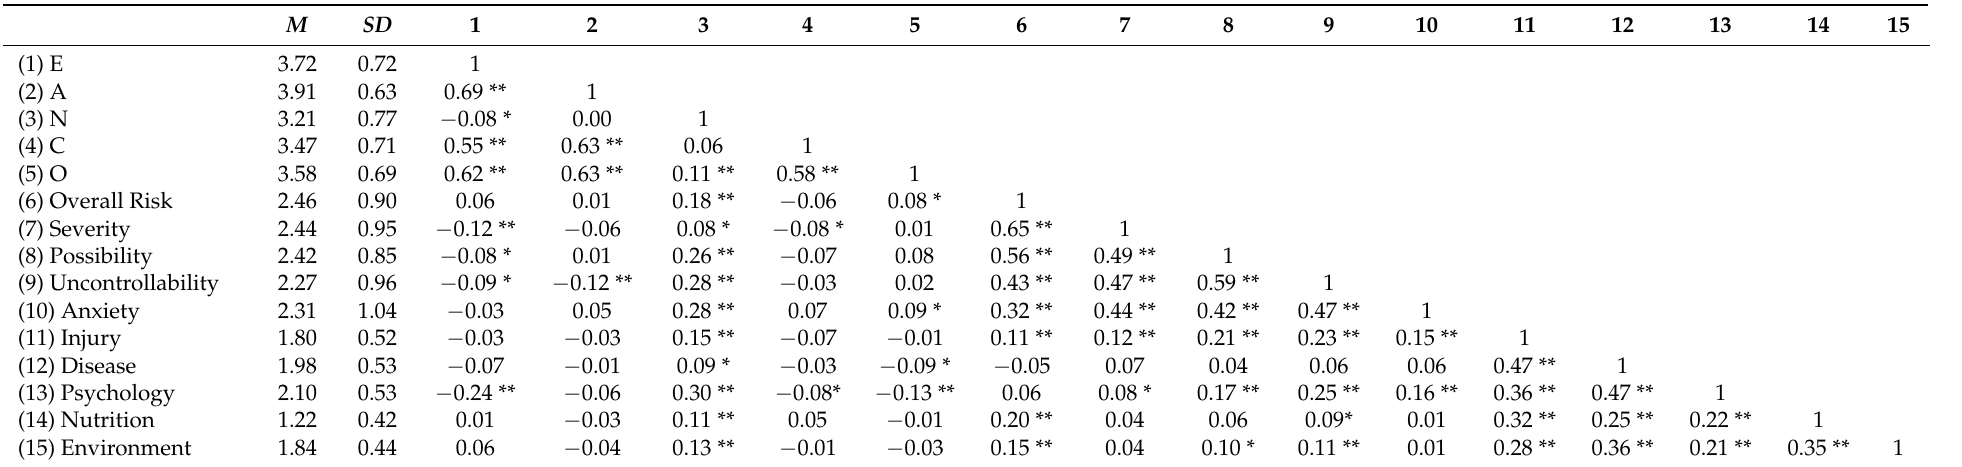
Table 4. Intercorrelations among variables for the total sample ( n =